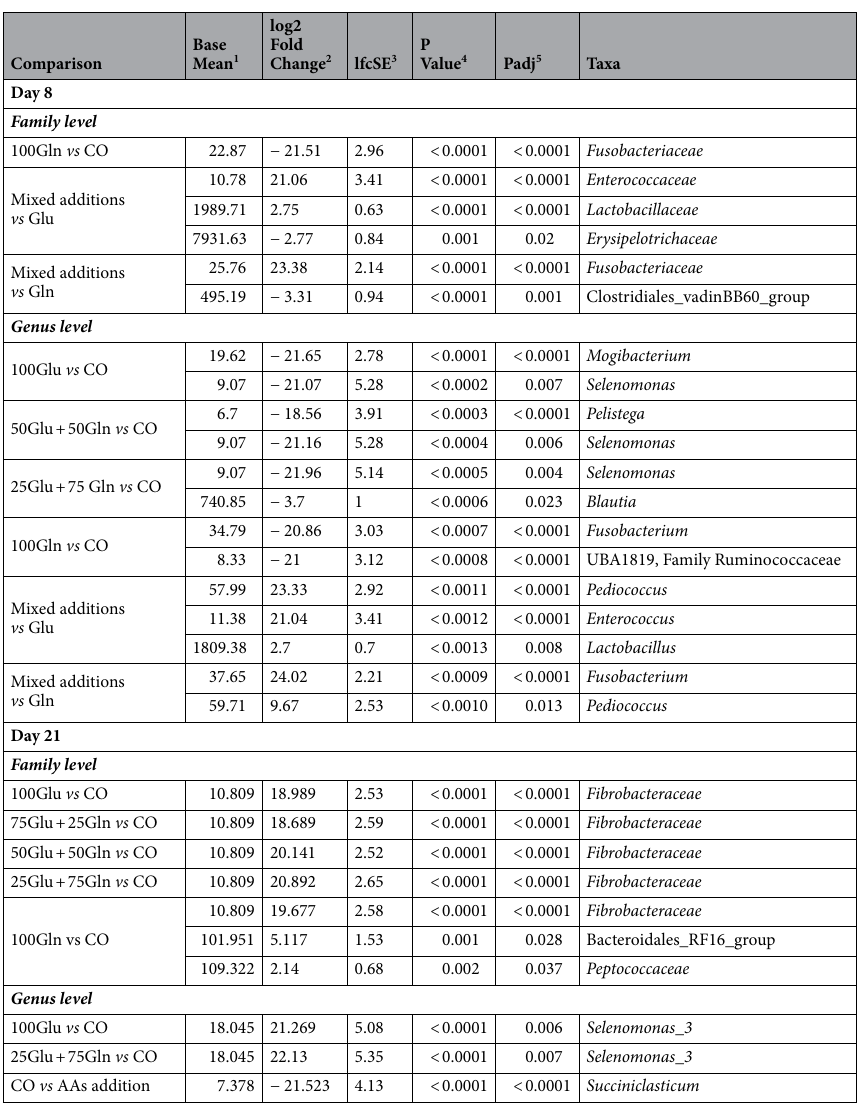
Table 4 shows the effect of dietary supplementation on the intestinal morphology measurements at d8 and d21. At d8, no difference due to diet was observed for villus height, villus width, crypt depth, and the number of goblet cells and duodenal glands. However, at d8, in the duodenum, the number of duodenal glands was higher in the 100Gln group as compared with the other groups supplemented with mixed doses of AAs ( P = 0.048); a quadratic effect of the Glu:Gln ratio was observed ( P = 0.048). At d8, in the jejunum, the number of goblet cells was lower in the CO group as compared with the 50Glu + 50Gln group ( P = 0.05); in the ileum, the villus height tended to be higher in the 100Glu group as compared with the other groups supple- mented with mixed doses of AAs ( P = 0.097). The villus width tended to be higher in the CO group as compared with the 100Glu group ( P = 0.079) and the number of goblet cells tended to increase linearly with the Gln dose ( P = 0.090). No difference due to diet was observed for the interstitial score in any of the intestinal segments at d8. Diet influenced the intraepithelial score in the jejunum at d8; the CO group had a higher probability of hav- ing a higher intraepithelial lymphocyte score as compared with the groups supplemented with Glu, Gln or both ( P < 0.016), and the 25Glu + 75Gln group showed a lower probability of a high intraepithelial lymphocyte score